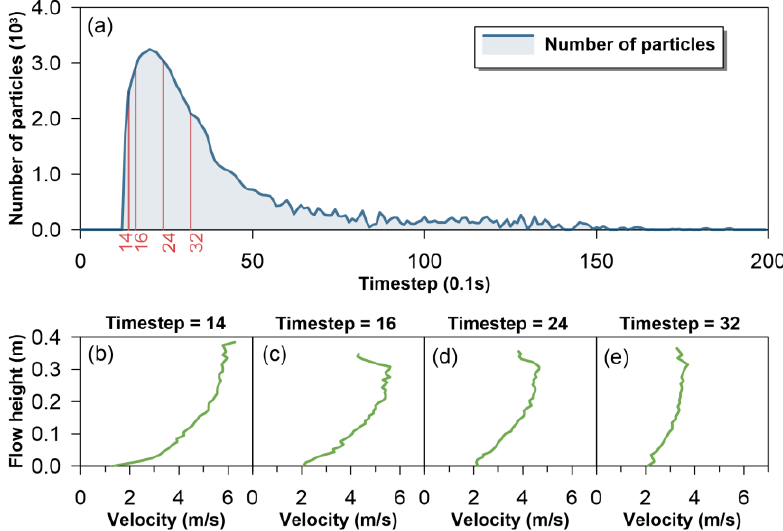
Figure 4. The result of velocity profile in four timesteps. ( a ) The number of particles over time. ( b ) The velocity profile at timestep = 14. ( c ) The velocity profile at timestep = 16. ( d ) The velocity profile at timestep = 24. ( e ) The velocity profile at timestep =